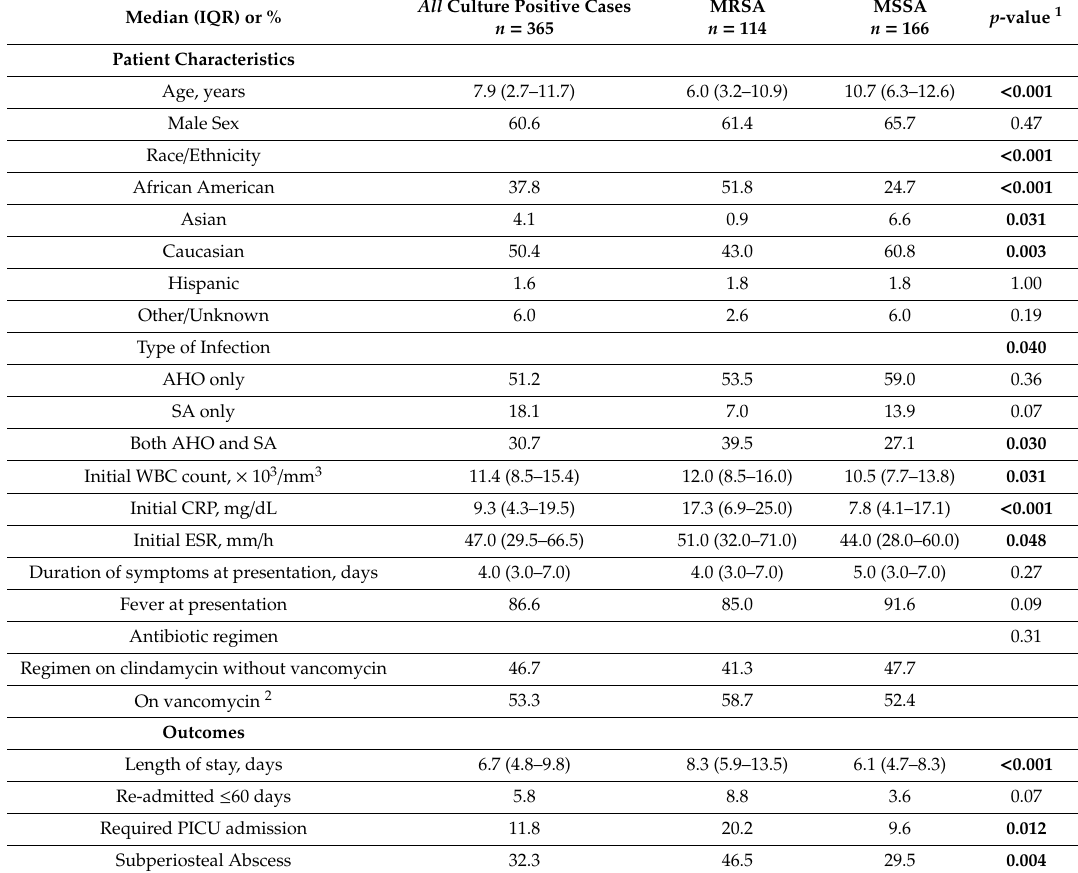
Table 1. Patient characteristics and outcomes based on pathogen isolated.